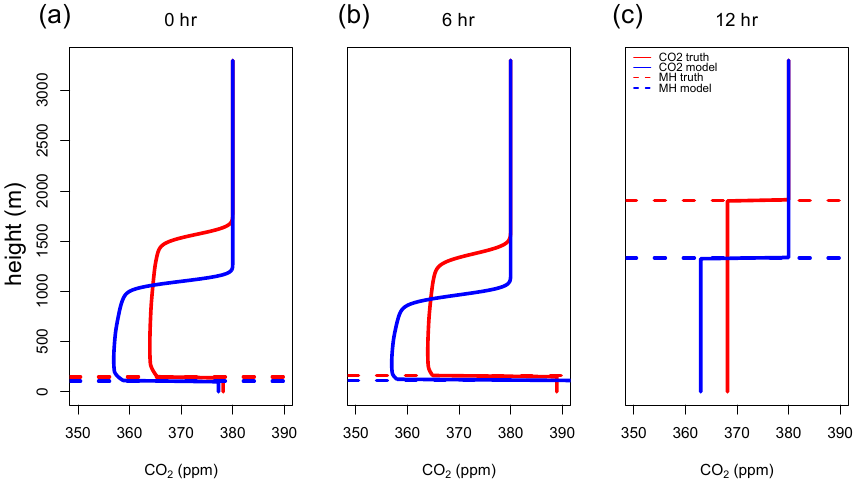
Fig. 4. Three profiles calculated by the conceptual model (Eq. 2) for the model (blue line) and the truth (red line) at different times of the day (vertical lines): during night time (a) and in the morning (b) a residual layer remains from the previous day above the ML (dashed horizontal lines). At noon the residual layer was completely entrained (c)